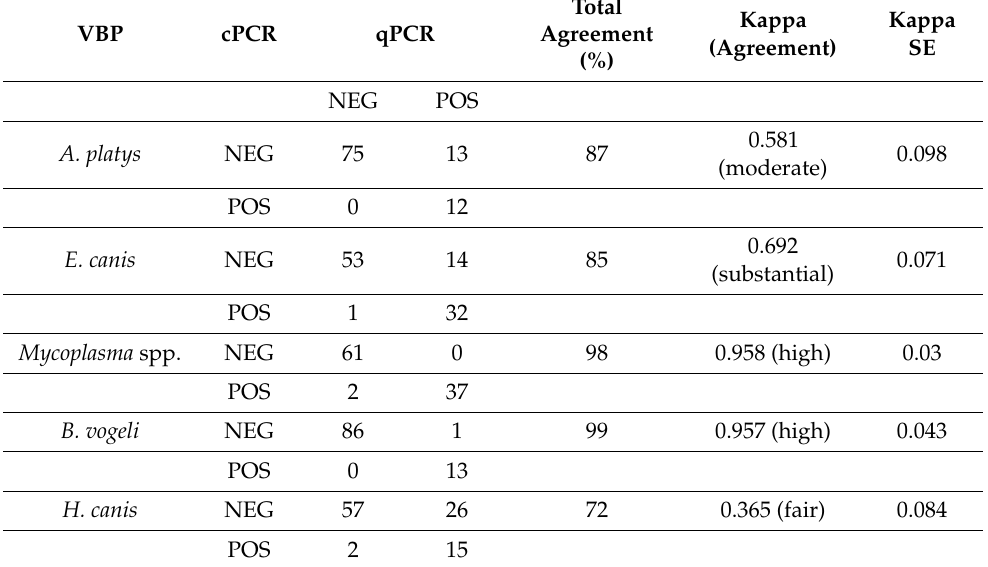
Table 2. cPCR vs. multiplex qPCR agreement statistics for five VBPs. POS = positive, NEG = negative, SE = standard error. Kappa agreement level defined as poor if coefficient ( k ) is ≤ 0.20, fair agreement if 0.21 ≤ k ≤ 0.40, moderate agreement if 0.41 ≤ k ≤ 0.60, substantial agreement if 0.61 ≤ k ≤ 0.80